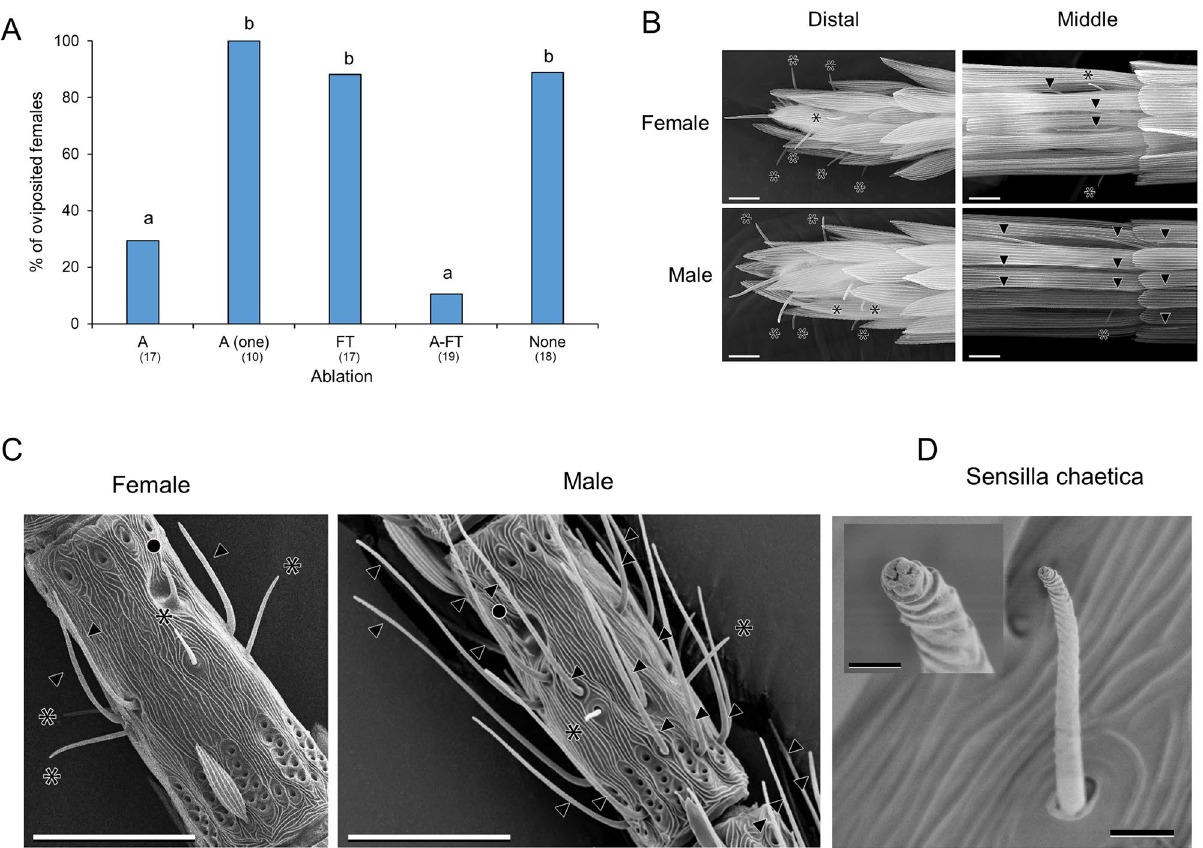
Figure 1. Host recognition via chemosensory organs. ( A ) Oviposition responses of Lyonia race females after ablating the following chemosensory organs, A: antennae; A (one): one of pair of antennae; FT: foreleg tarsi; A-FT: antennae and foreleg tarsi; None: untreated. Different letters indicate statistically significant differences among the treatments by Fisher’s exact test, p < 0.01. Numbers in parentheses represent the number of tested animals. ( B ) SEM images of distal and middle portion of female and male antennae. Scale bars: 10 μm. ( C ) Middle portion of antennae without scales. Scale bars: 25 μm. ( D ) Sensilla chaetica of female. Scale bar: 2 μm for whole image of sensillum and 0.5 μm for the image of tip. Symbols indicated sensilla chaetica (asterisk), sensilla basiconica (filled circle) and sensilla trichodea (filled